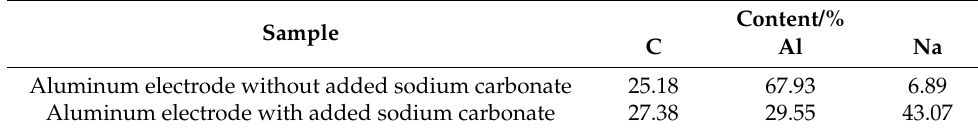
Figure 5. XPS spectra of different elements. ( a ) Al element, ( b ) Na element. Table 1. Elemental analysis results of aluminum electrodes.